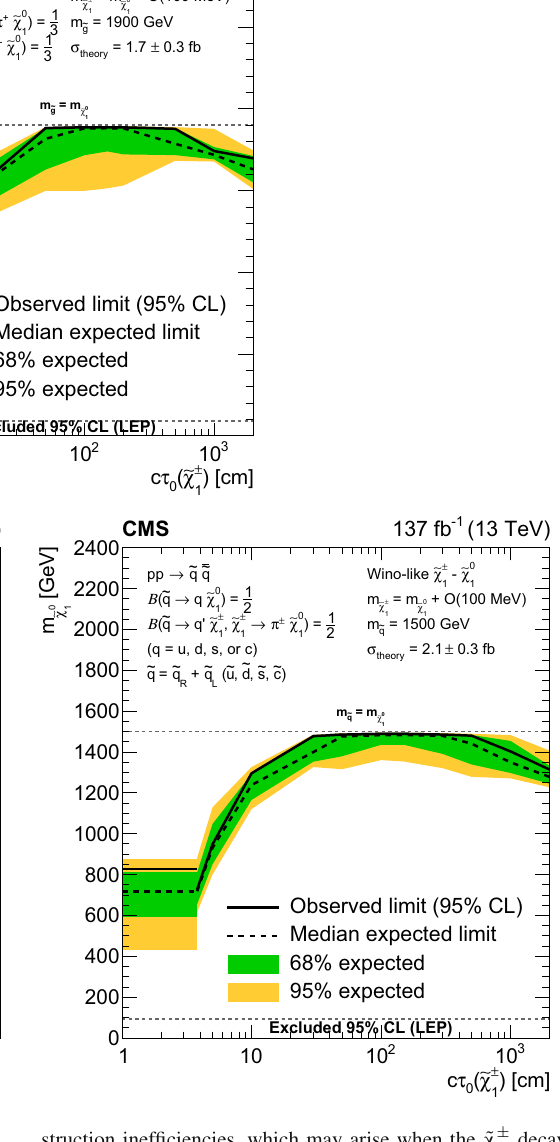
Fig. 20 Exclusion limits at 95% CL on the ˜ χ 0 + O ( 100 MeV ) , as a function of the ˜ χ ± m ˜ χ 0 1 (upper)directgluinoand(lower)directlight-flavor(u,d,s,c)squarkpair production, as obtained for representative gluino and squark masses. The gluinos decay to light-flavor quarks. For direct squark pair produc- tion, we assume either (lower left) one–fold or (lower right) eight–fold squark degeneracy. The area enclosed by the solid (dashed) black curve represents the observed (median expected) exclusion region, while the innergreen(outeryellow)bandindicatestheregioncontaining68(95)% ofthedistributionoflimitsexpectedunderthebackground-onlyhypoth- esis. At short decay lengths, horizontal exclusion lines are obtained from the inclusive M T2 search, as this is not affected by track recon-